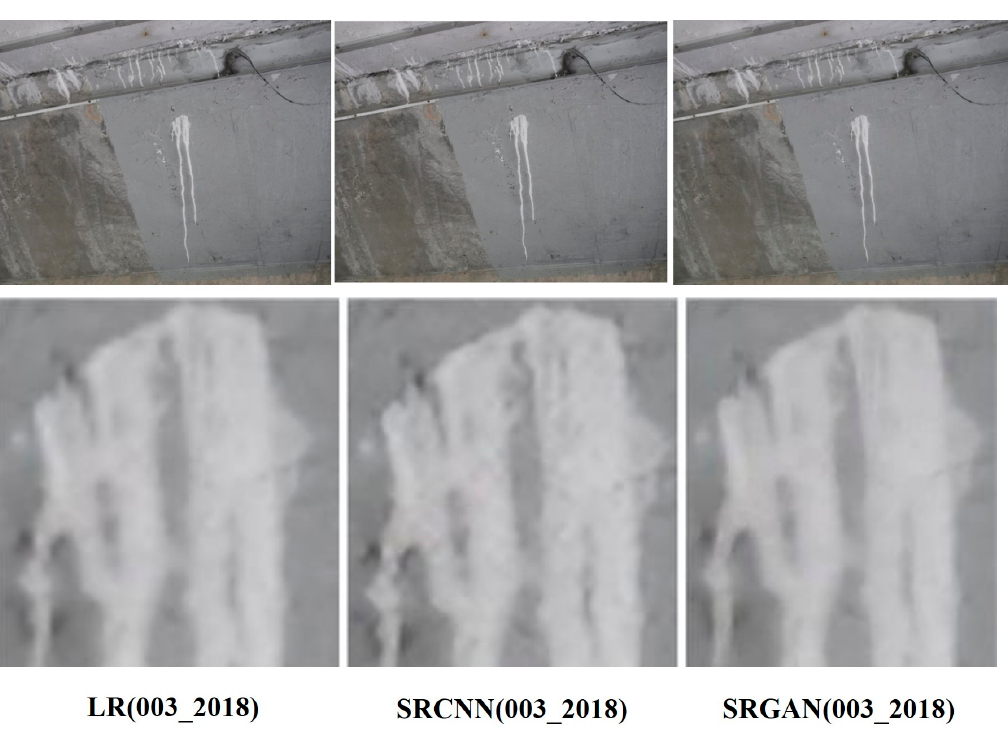
Figure 9. Experimental image result: real bridge image set.